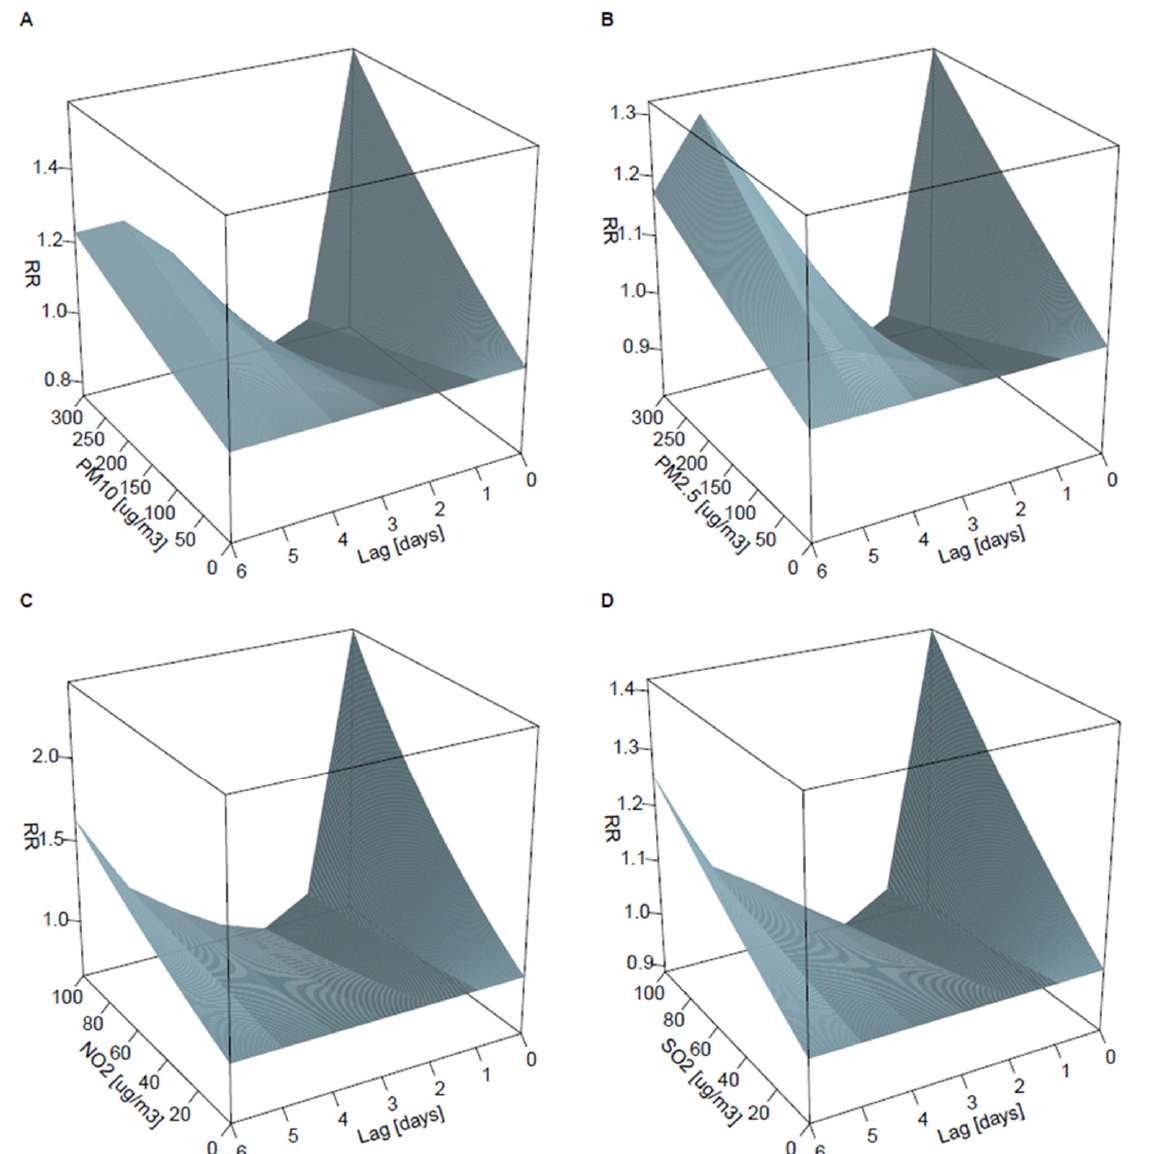
Figure 3. Risk for admission due to J45 or J46 (“asthma”) depending on time since exposure (lag) and concentrations of PM 10 ( A ), PM 2 . 5 ( B ), NO 2 ( C ), and SO 2 ( D ). RR, rate, ratio.